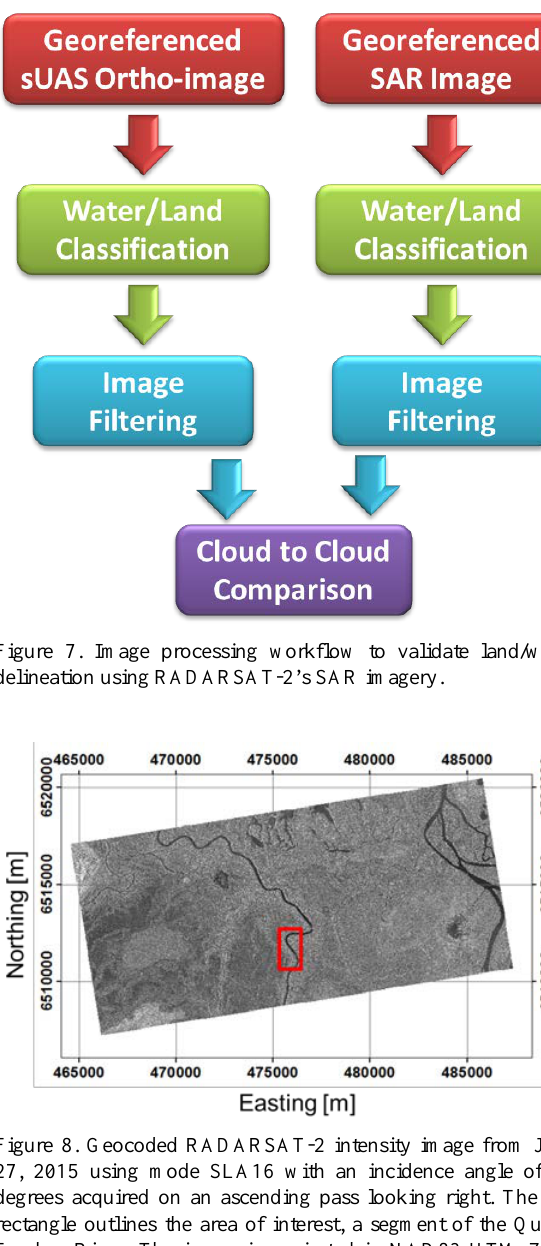
extracted from the SAR image.